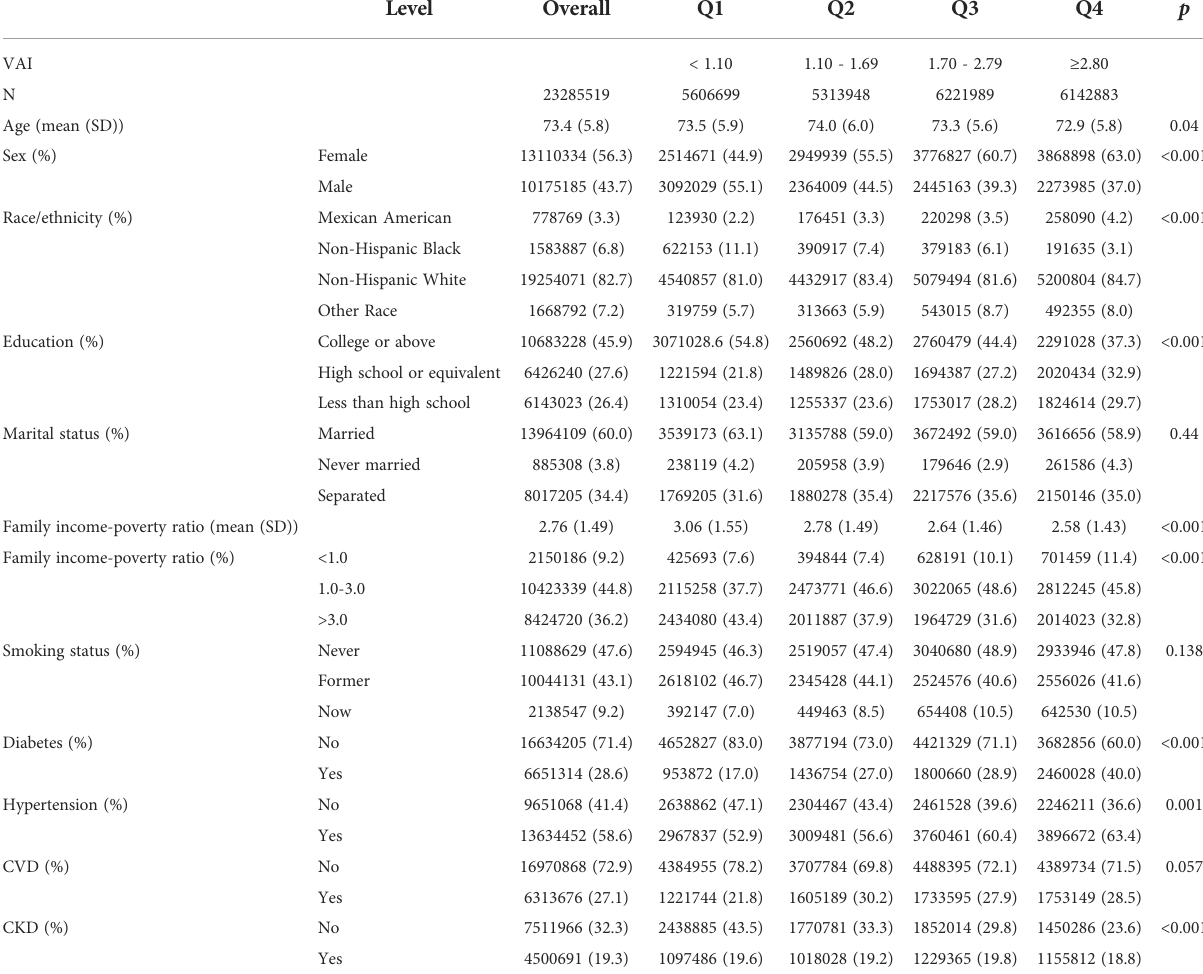
TABLE 1 Weighted characteristics of the study participants by the quartiles of